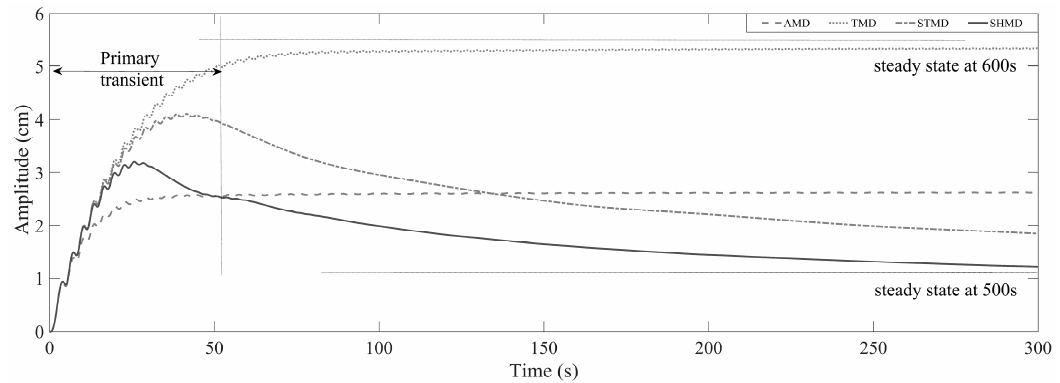
Figure 8. Transient and steady ‐ state response of the different control device configuration under harmonic loading at tuning frequency (excitation frequency 1 rad/s).